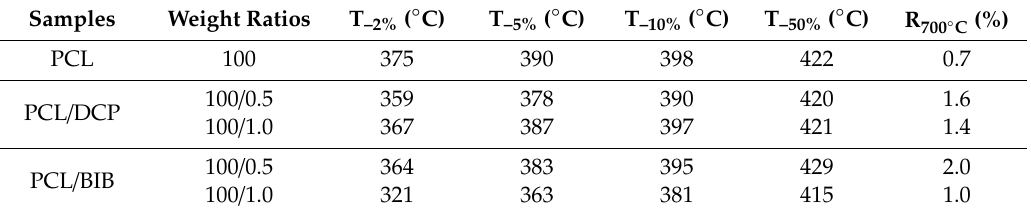
Table 1. Thermal degradation parameters of PCL and PCL modified by the peroxides.